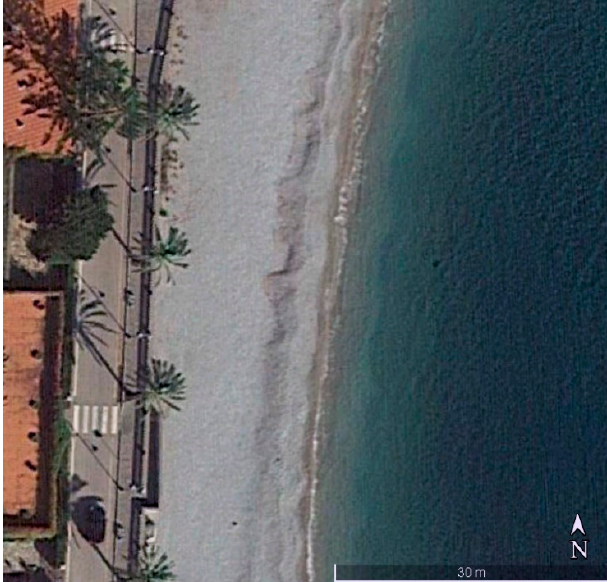
Figure 10. Storm berm crest on the Northern Cell, October 2018 (Google Earth).